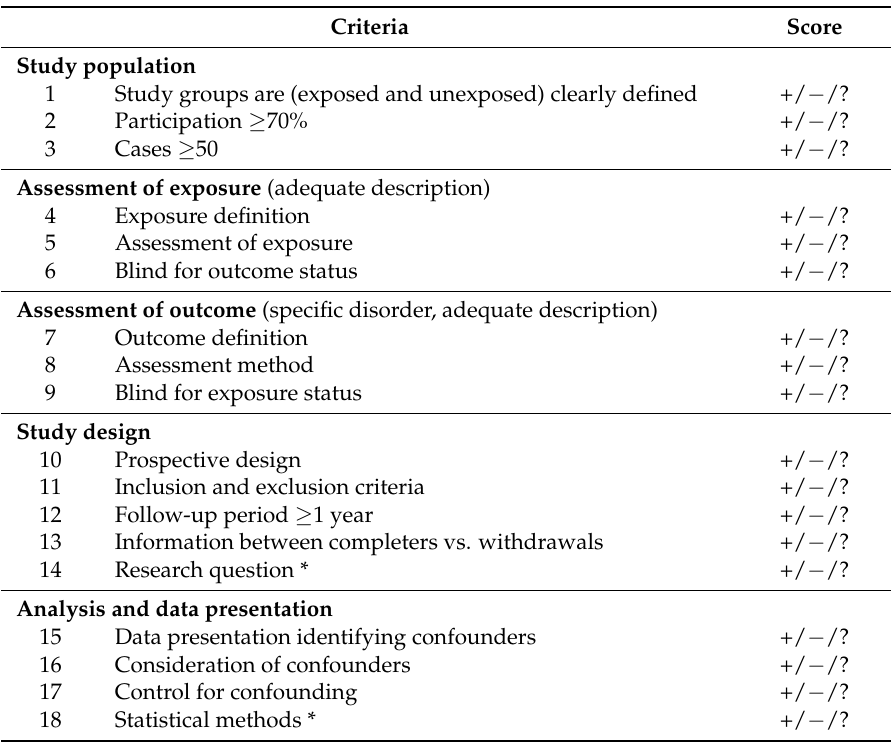
Table 1. Applied general methodological quality assessment (study